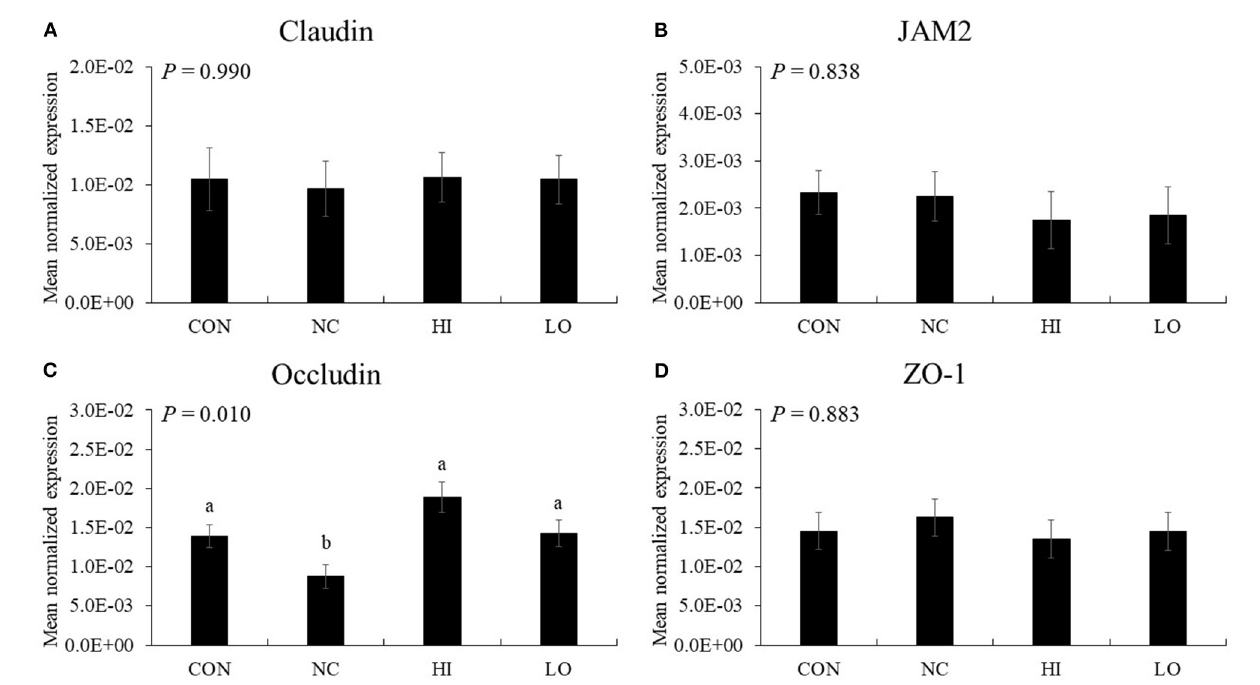
FIGURE 10 | Transcripts of tight junction protein in jejunum of chickens fed diet supplemented with maltol during infection with E. maxima in experiment 2. CON, basal diet; NC, basal diet for infected chickens; HI, maltol at 10.0 mg/kg feed; LO, maltol at 1.0 mg/kg feed; all chickens except CON were infected by oral gavage at day 14 with 1.0 × 10 4 oocysts/chicken of E. maxima. a,b Bars with no common letter differ significantly ( P < 0.05). Each bar represents the mean ± SEM ( n = 4). The data were collected at day 20 (6 days post-infection). Transcript levels of the tight junction proteins were measured using quantitative RT-PCR and normalized to GAPDH transcript